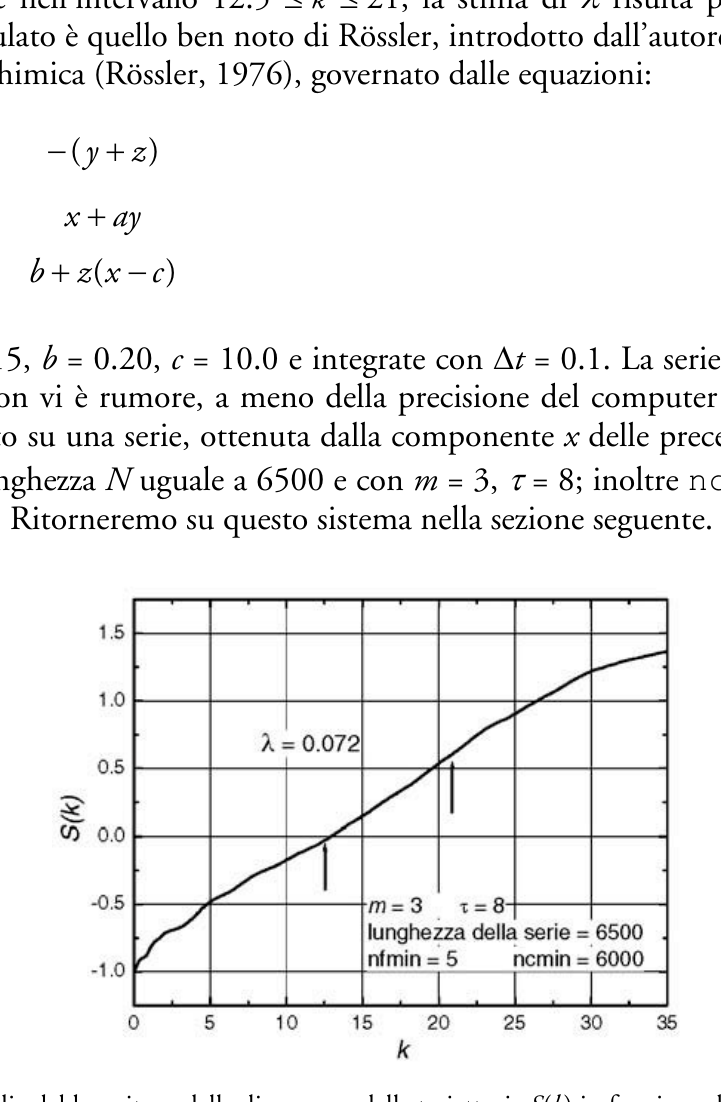
Figura 3 – Media del logaritmo della divergenza delle traiettorie S ( k ) in funzione del tempo calcolata sull’attrattore di Rössler. Le frecce individuano la parte lineare della curva, la cui pendenza fornisce la stima dell’esponente di Lyapunov massimo (cid:79)(cid:3) = 0.072. I parametri usati sono riportati in